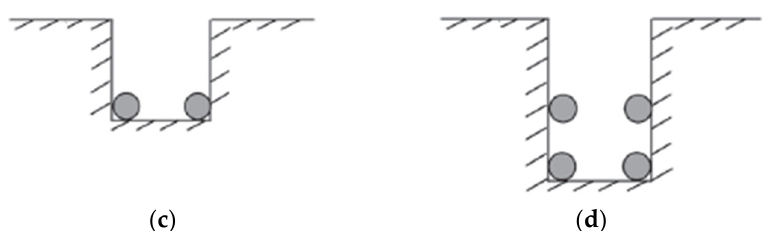
Figure 6. Horizontal ground heat exchanger. ( a ) Single pipe per trench; ( b ) Two pipes (over/under); ( c ) Two pipes (side by side); ( d ) Four pipes per trench. As shown by Sanaye in [19].